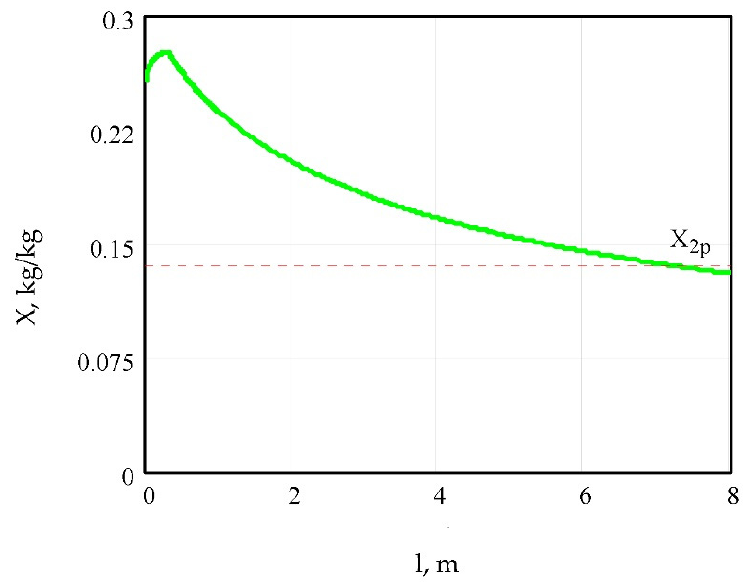
Figure 12. Moisture-content change in the function of the apparatus length.